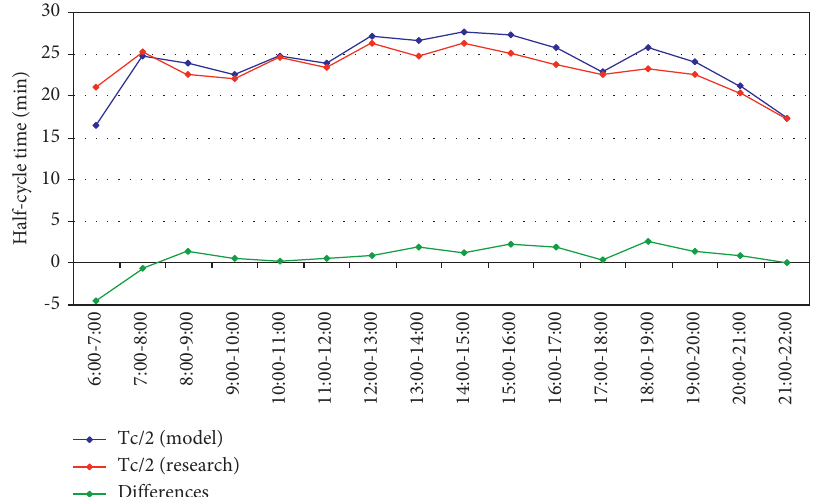
Figure 9: Comparative review of the realized values of the travel time and the values obtained in the model and differences between the two, by hours in a day, for direction A.